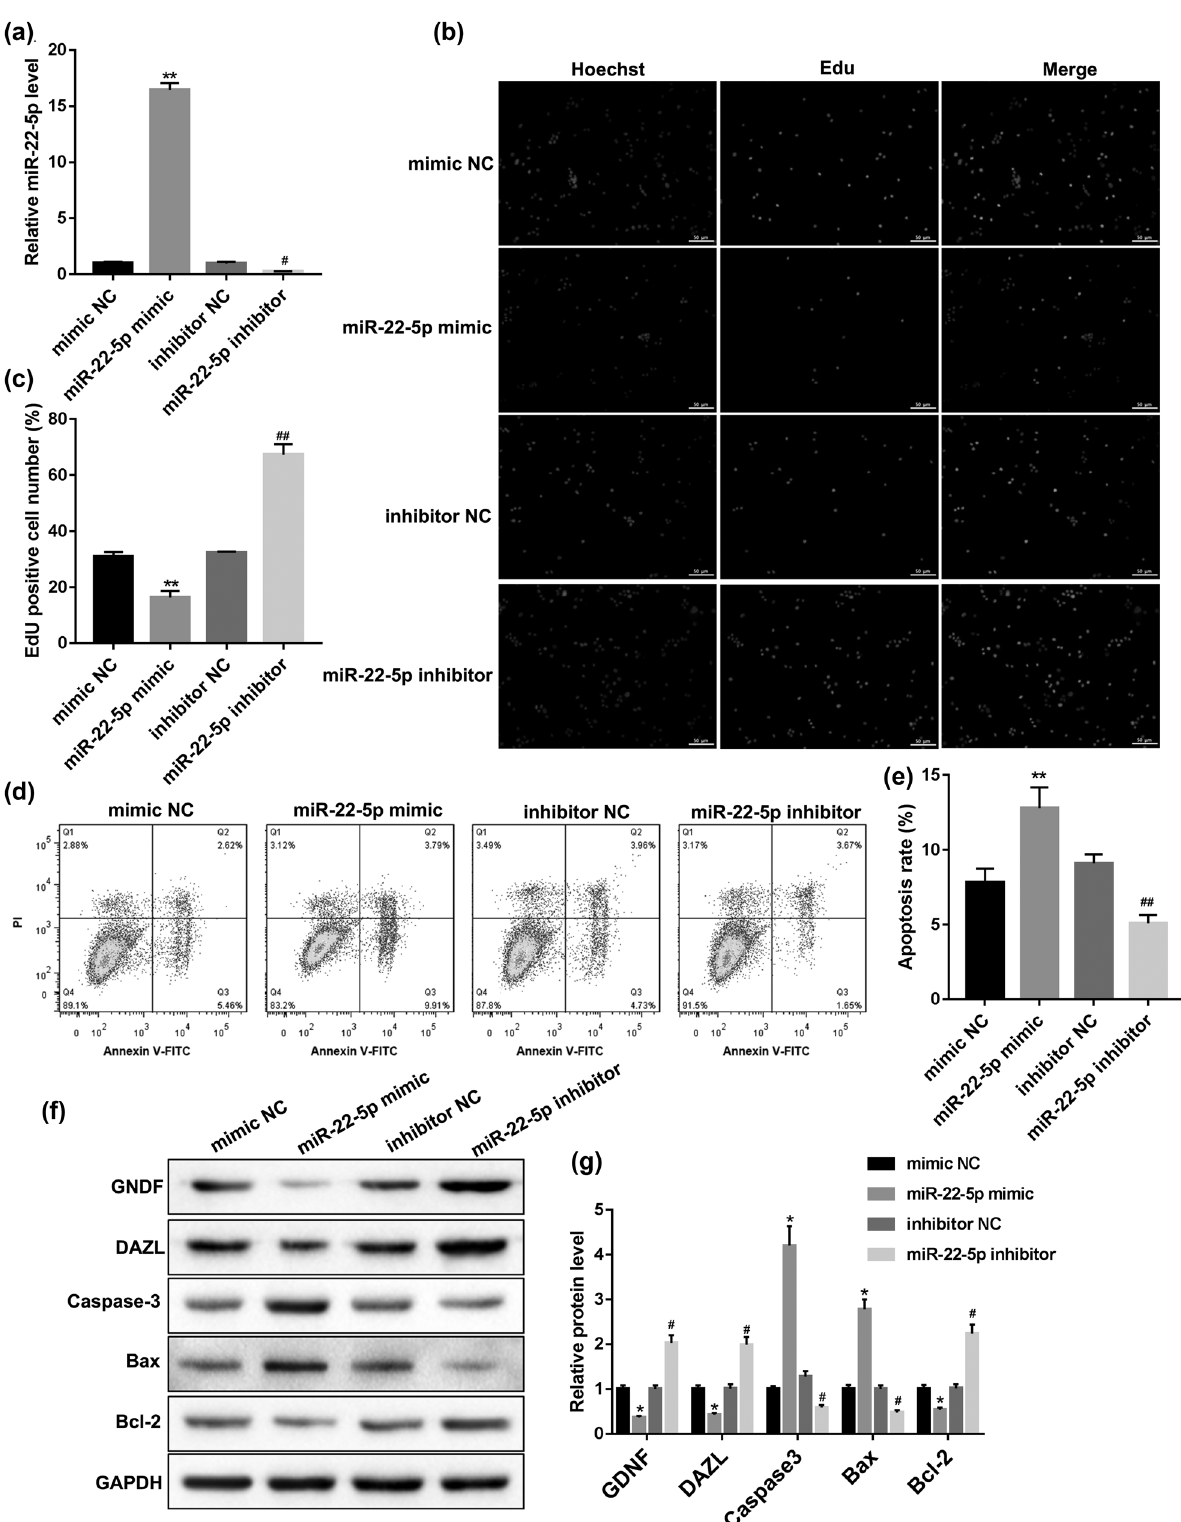
Figure 2: E ff ect of miR - 22 - 5p on SSCs. Human SSCs were transfected with the miR - 22 - 5p mimic or miR - 22 - 5p inhibitor, respectively. ( a ) The miR - 22 - 5p overexpression and interference e ffi ciency were detected by QRT - PCR. ( b and c ) Cell proliferation was measured by EdU staining. ( d and e ) Cell apoptosis was analyzed by Annexin V/PI staining. ( f and g ) The expression of SSC markers ( GDNF and DAZL ) and apoptosis - related proteins ( Caspase - 3, Bax, and Bcl - 2 ) were detected by western blot. * p < 0.05, ** p < 0.01 vs mimic NC; # p < 0.05, ## p < 0.01 vs inhibitor